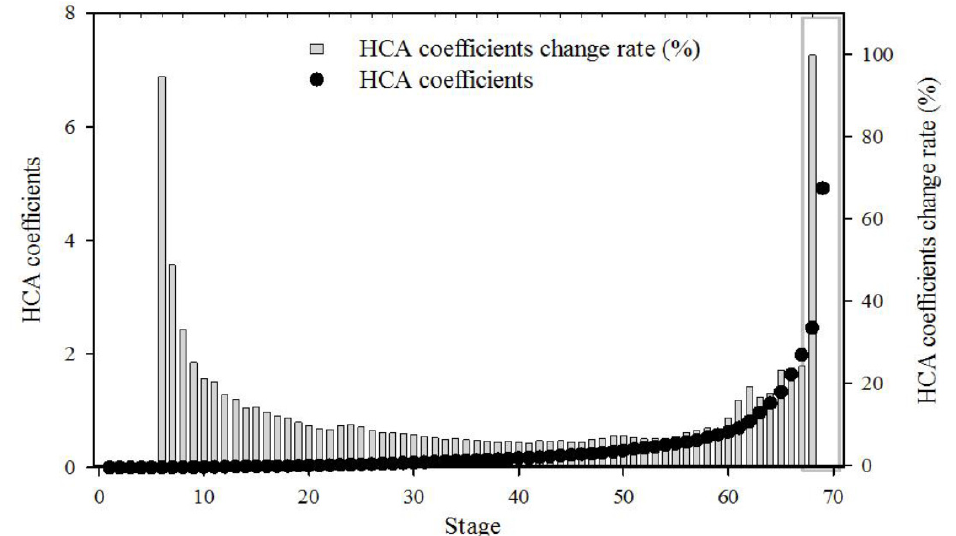
Figure A14. Relationship between hierarchical cluster analysis (HCA) coefficients and HCA coeffi- cients change rate.